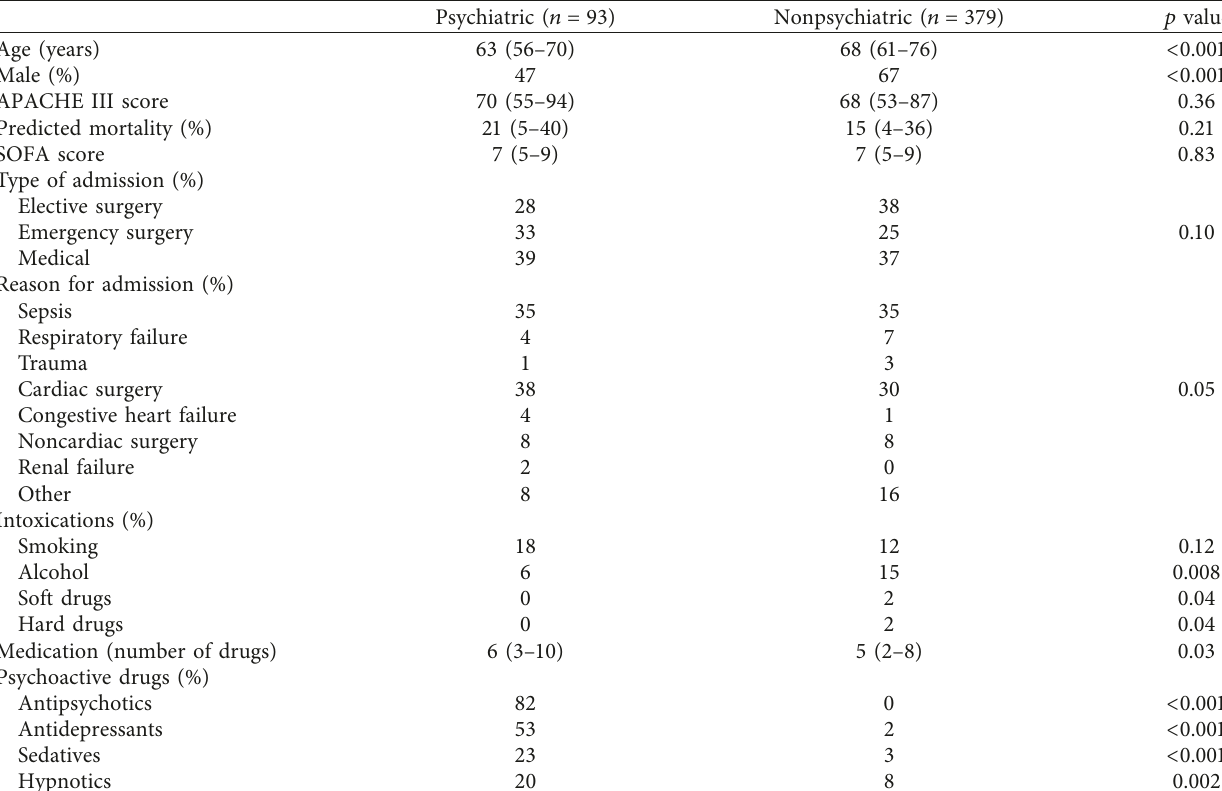
Table 1: Baseline characteristics.